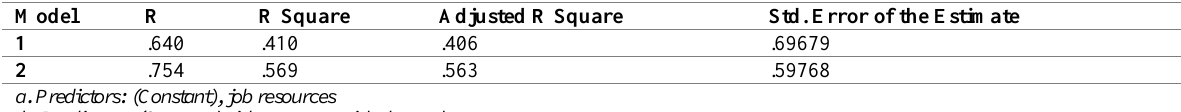
Table 5: Model summary for the moderating effect of job demand